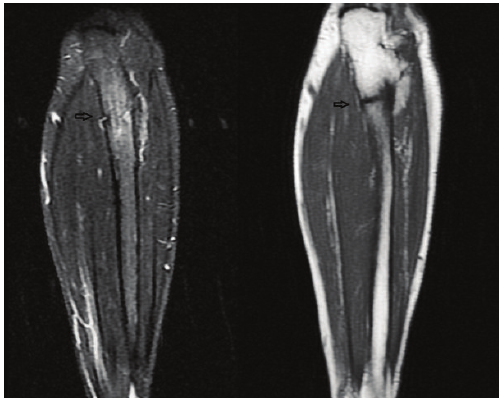
Figure 3: Coronal sections showing stress fracture line and sur- rounding soft tissue oedema in T1 and T2 sequences of the patient’s forearm